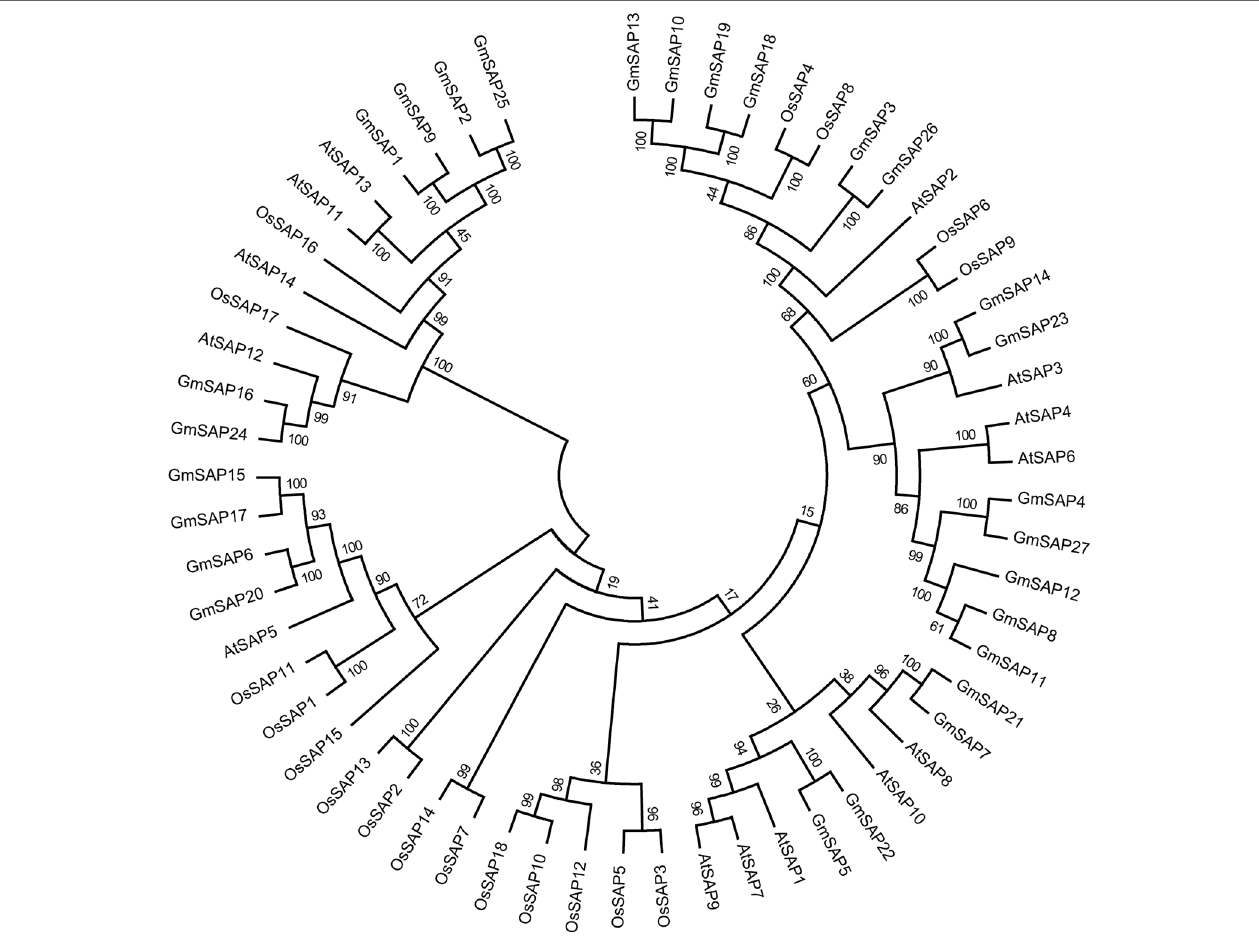
FiGURe 1 | Phylogenetic analyses of stress associated proteins (SAPs) from Arabidopsis , rice, and soybean. The full-length amino acid sequences of SAPs were aligned by Clustal X 2.0, and a phylogenetic tree was constructed using MEGA 6.0 by the neighbor-joining method with 1,000 bootstrap replicates.